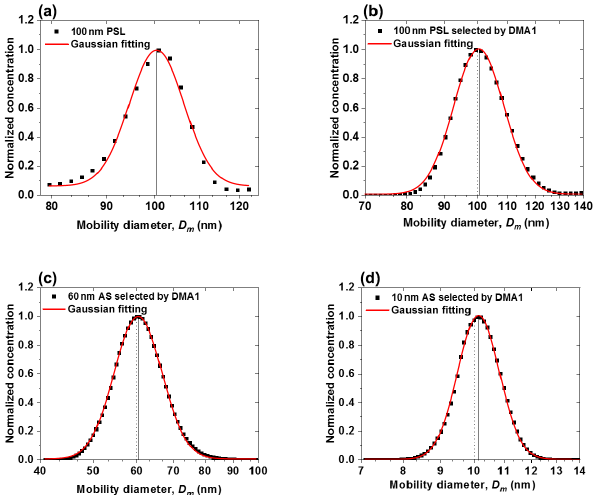
Figure 4. Mobility diameter hygroscopic growth factors ( g f ) of 100nm ammonium sulfate (AS) nanoparticles at 298K mea- sured in deliquescence mode. In comparison, the E-AIM model predicted growth factors of ammonium sulfate nanoparticles at 100nm. (a) RH e = RH a (75%, 75%) represents the RH e and RH a ; (b) RH e ≥ RH a + 3% (75%, 72%) represents the RH e and RH a ; and (c) RH s = RH a . (d) The enlarged view of the RH range of 70% to 84% in Fig. 4c. The (80%, 80%) points represent the RH s and RH a . RH s and RH e are the RH of sheath flow in the inlet of nano- DMA2 and in the excess air line, respectively. RH a is the RH of aerosol flow in the inlet of